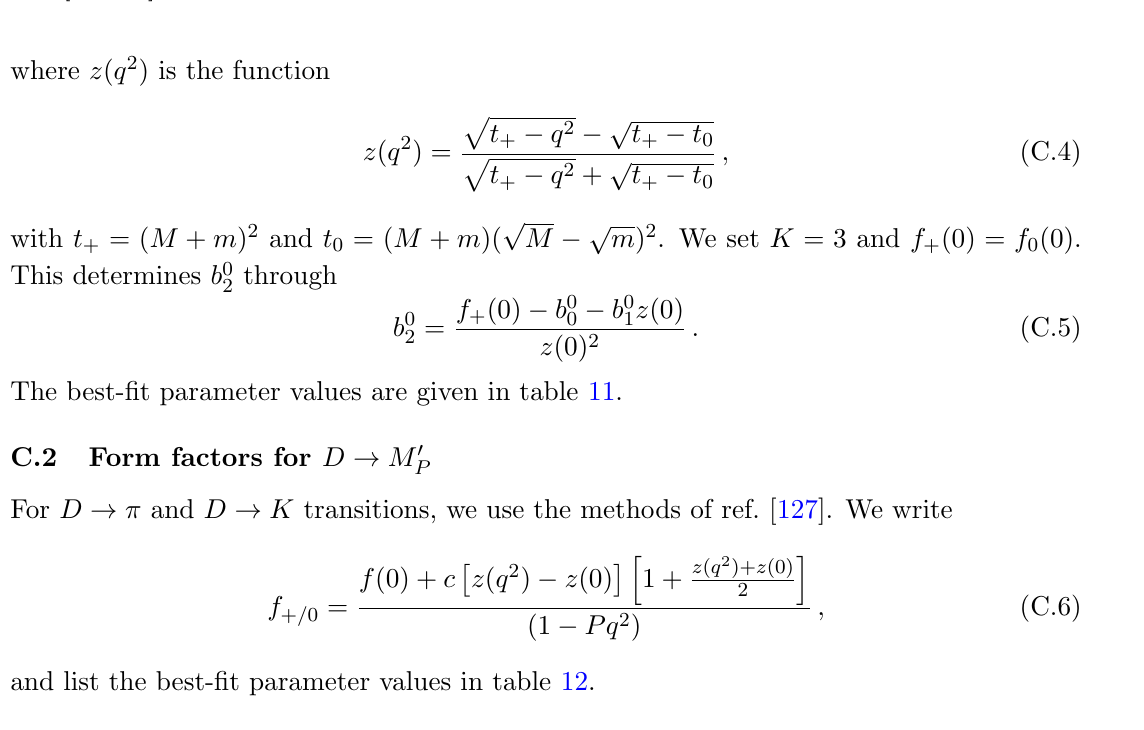
Table 12 . Best (cid:12)t parameters for the form factors in D ! K and D ! (cid:25) transitions from refs. [63,